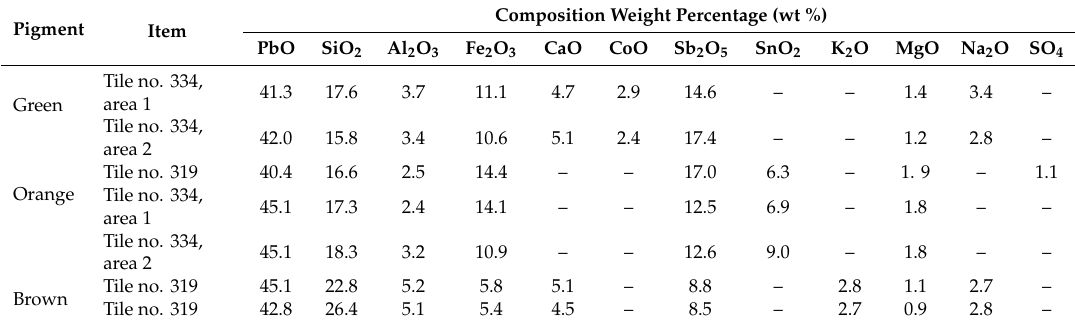
Table 3. Electron probe microanalysis with wavelength-dispersive X-ray spectroscopy (EPMA-WDS) chemical analysis of the Type A tile pigment